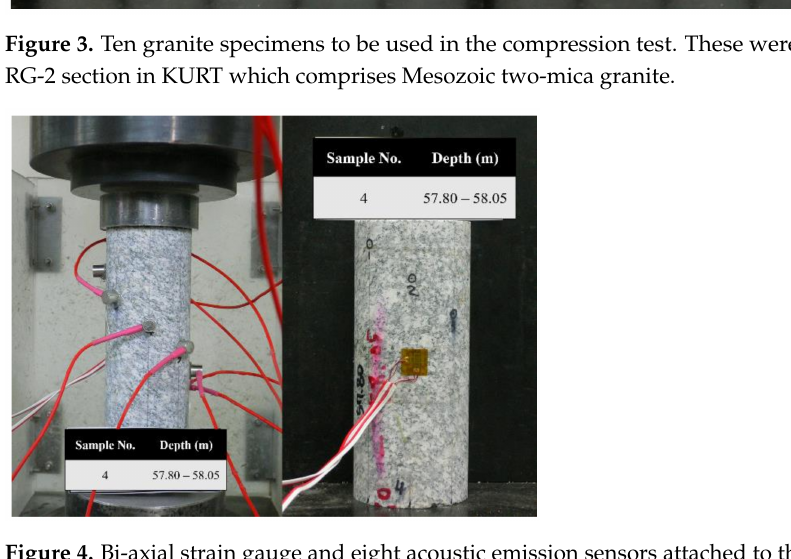
Figure 4. Bi-axial strain gauge and eight acoustic emission sensors attached to the specimen surface. The strain gauge was installed to the center of the vertical axis and AE sensors were attached in a spiral direction for a wide range of crack